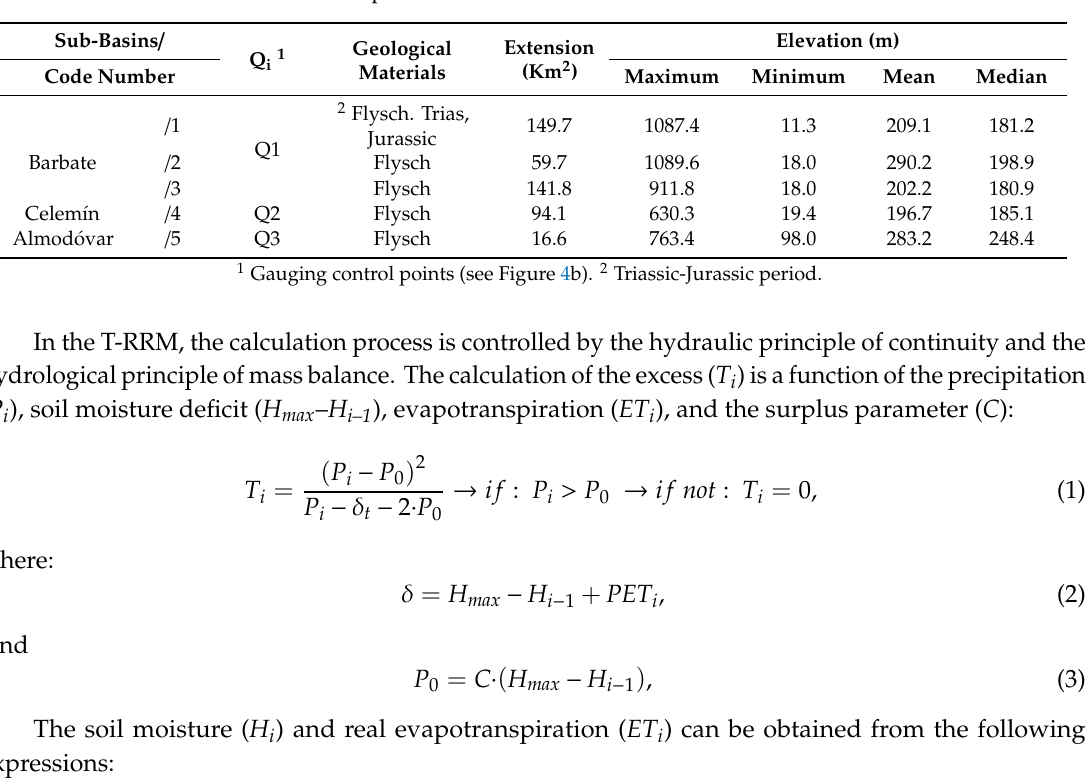
Table 1. Main morphometric characteristics of the studied